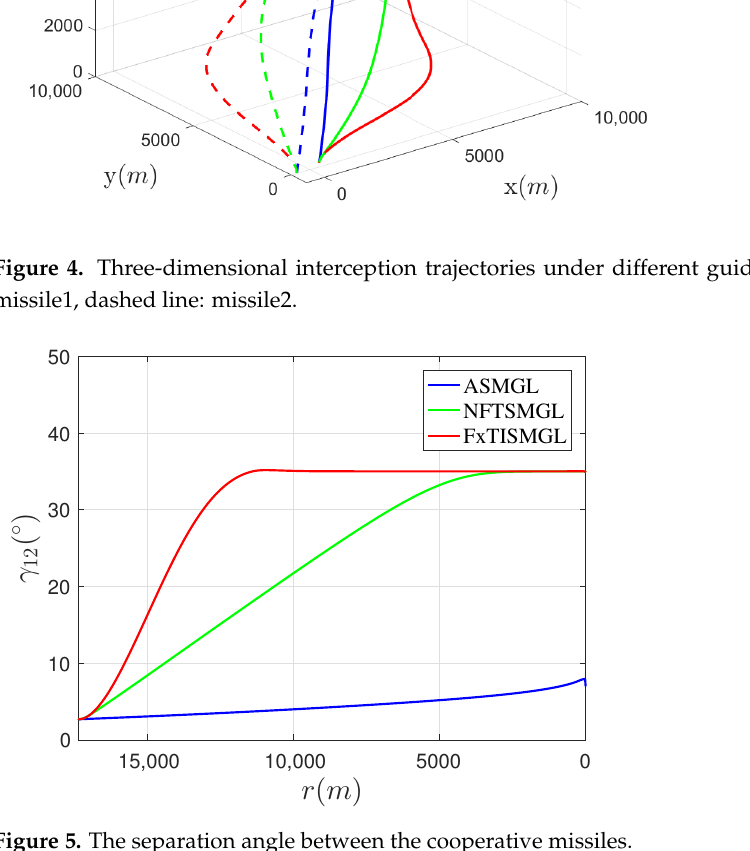
Figure 5. The separation angle between the cooperative